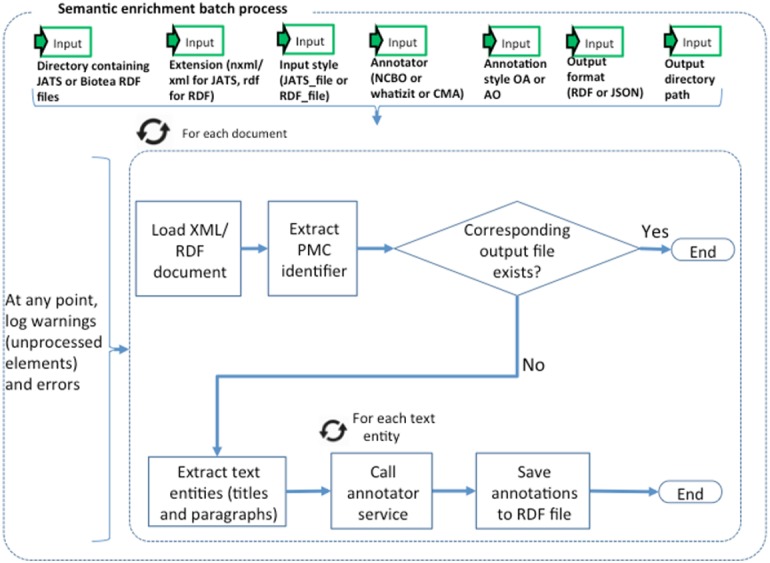
Semantic enrichment.